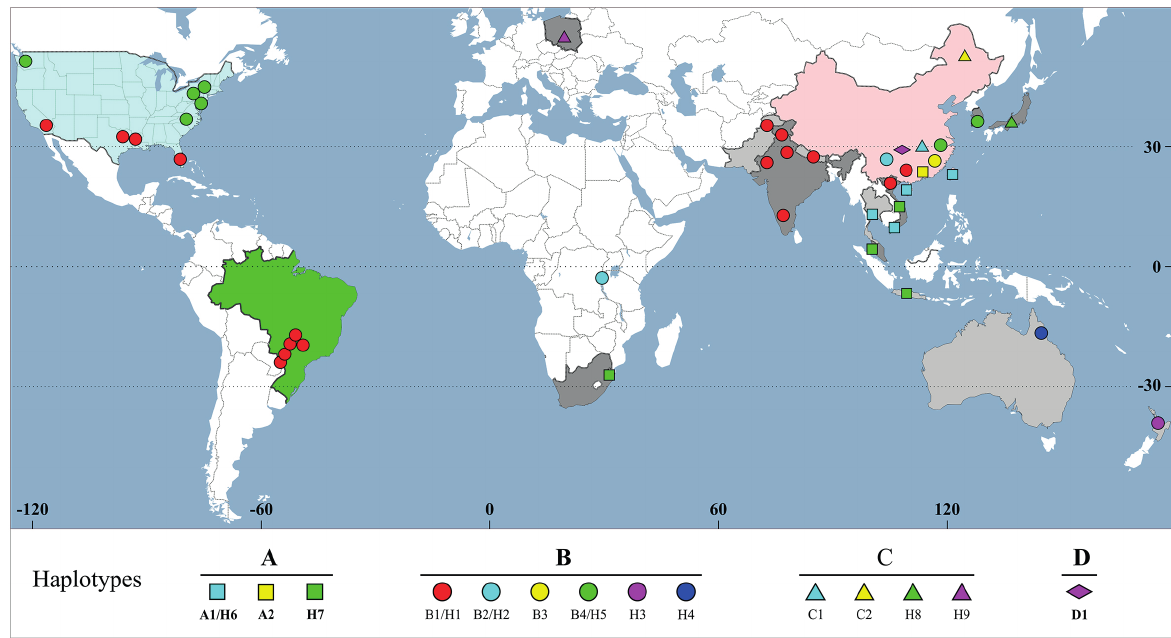
Figure 1 - Distribution of the Hydrilla verticillata haplotypes native and introduced worldwide. Our data (Brazil) compared with world data retrieved from Madeira et al. (2004, 2007) and Zhu et al.